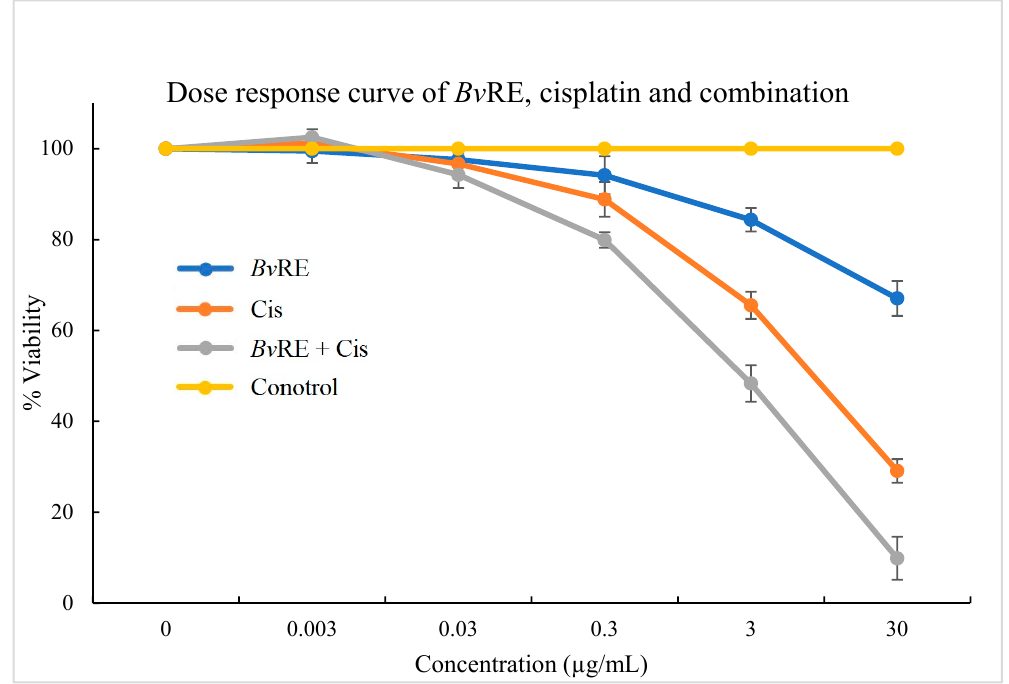
Figure 2. MTT assay dose-response curve of Berberis vulgaris root extract ( Bv RE), cisplatin, and their combination on HeLa cells.